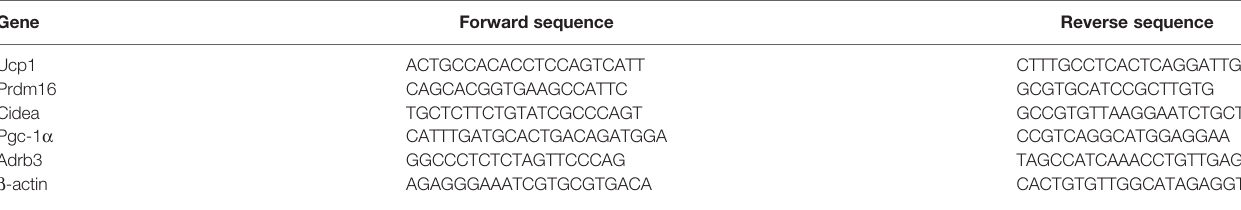
TABLE 2 | Primer sequences for RT-qPCR.